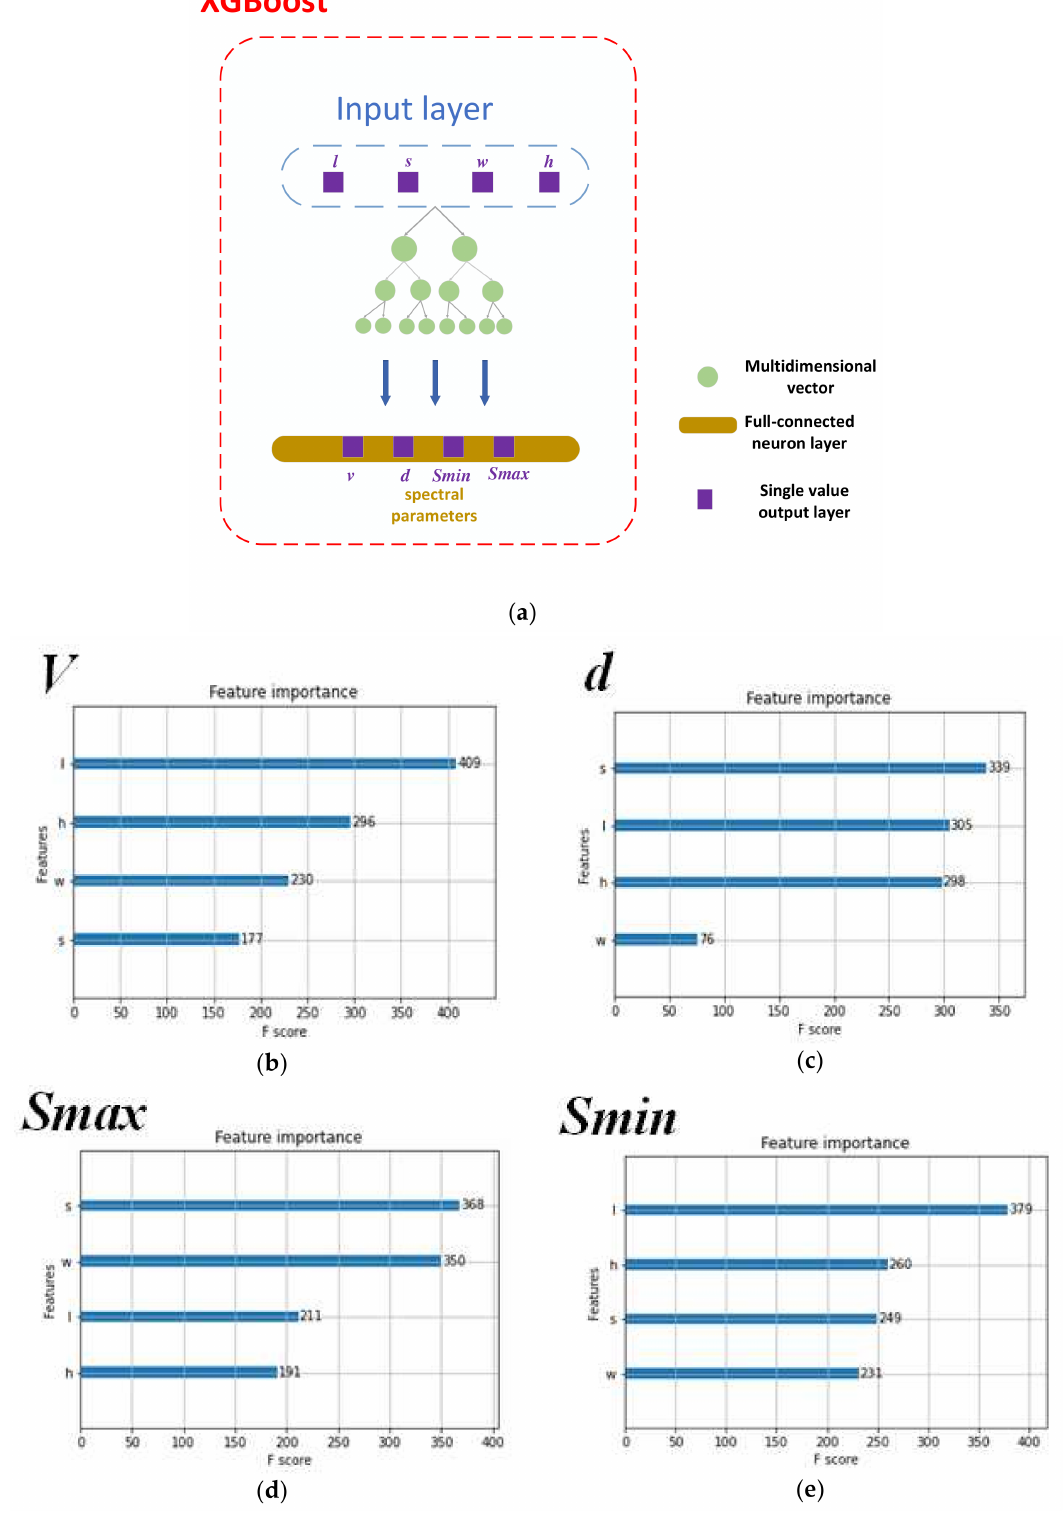
Figure 3. ( a ) MMLPM basic structure; ( b ) the corresponding optimal value with phase velocity; ( c ) the corresponding optimal value with phase velocity flatness; ( d ) the corresponding optimal value with Smax; ( e ) the corresponding optimal value with Smin